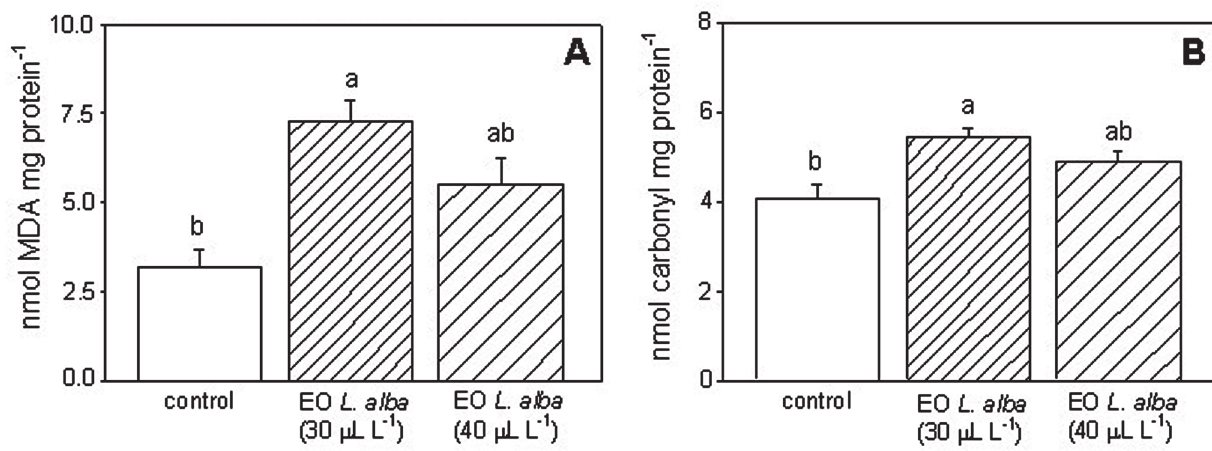
Fig. 3. TBARS (A) and protein carbonilation (B) levels in the liver of silver catfish ( Rhamdia quelen ) transported in plastic bags containing water treated with the essential oil from Lippia alba . The values are expressed as the means ± SEM. Different letters indicate difference levels of significance between the treatments